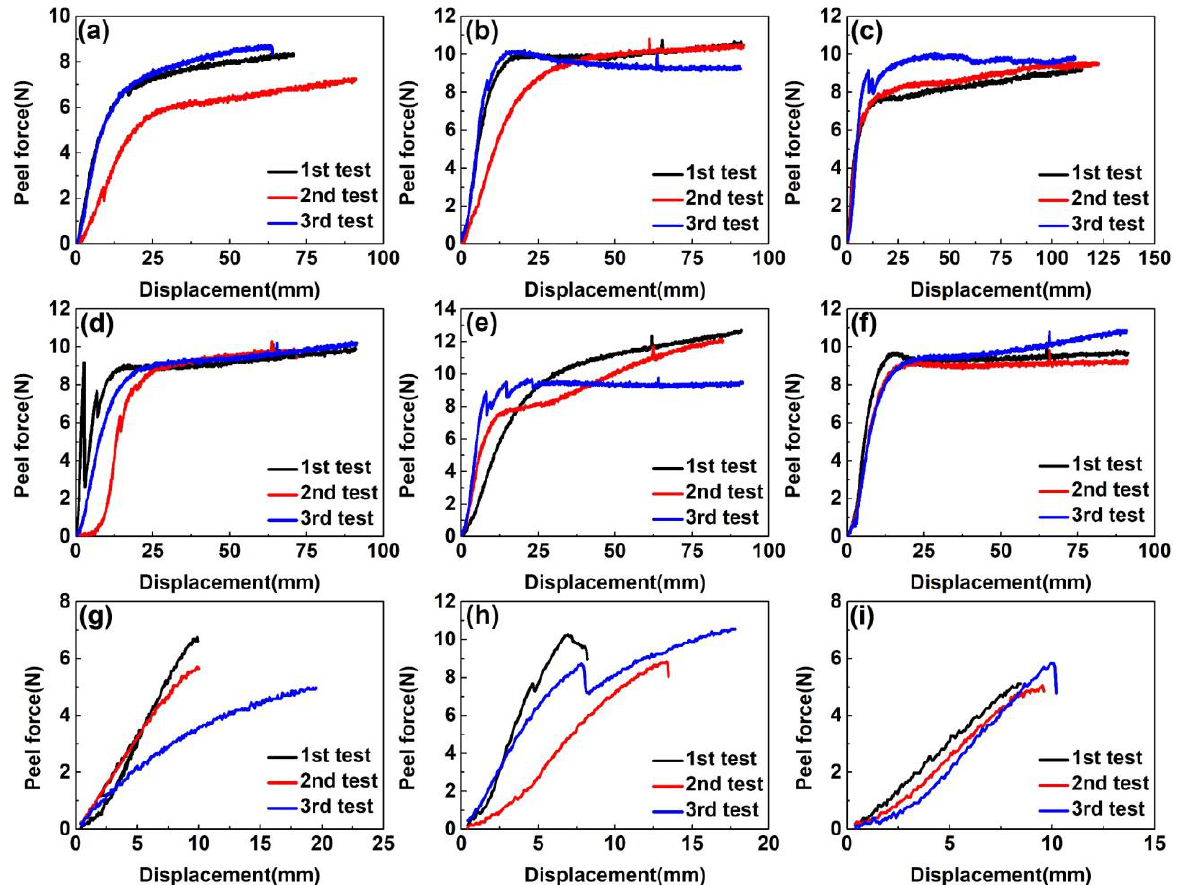
Figure 3. The peel curve of CFRP/EPDM composites. ( a ) CFRP/EPDM/DCP, 160 °C, 1 h. ( b ) CFRP/EPDM/DCP/S, 160 °C, 1 h. ( c ) CFRP/EPDM/DCP/TAIC, 160 °C, 1 h. ( d ) CFRP/EPDM/DCP, 170 °C, 1 h. ( e ) CFRP/EPDM/DCP/S, 170 °C, 1 h. ( f ) CFRP/EPDM/DCP/TAIC, 170 °C, 1 h. ( g ) CFRP/EPDM/DCP, 180 °C, 1 h. ( h ) CFRP/EPDM/DCP/S, 180 °C, 1 h. ( i ) CFRP/EPDM/DCP/TAIC, 180 °C, 1 h.